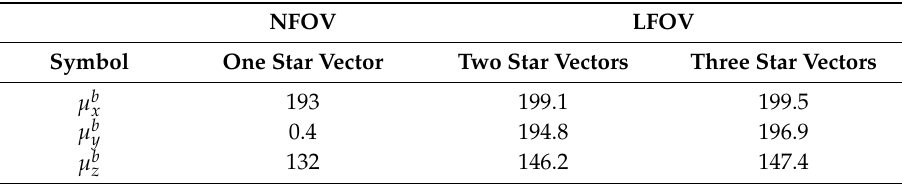
Table 2. The estimated value of installation errors in Case 2 (unit: